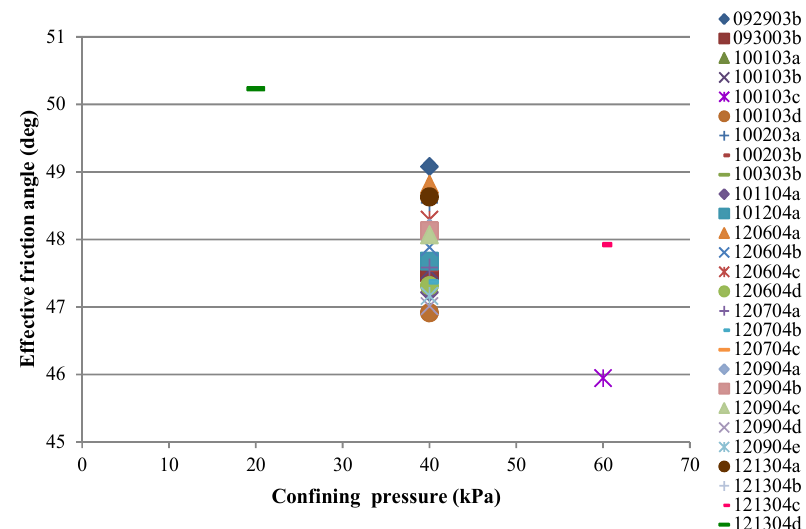
Figure 6 . Mohr’s circles of sand specimens prepared by the dry pluviation method.